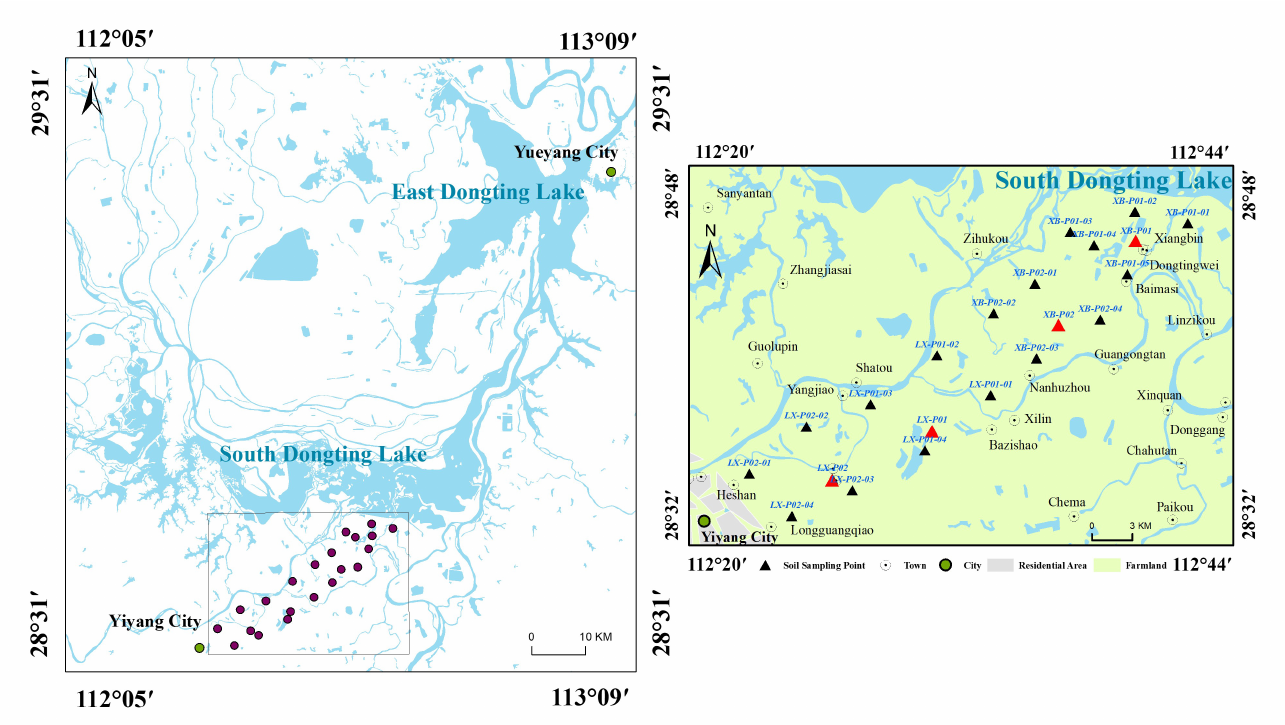
Figure 1. The study area of the present study near South Dongting Lake and the distribution of sampling sites (red triangles represent profile sampling points, whereas black triangles represent topsoil sampling